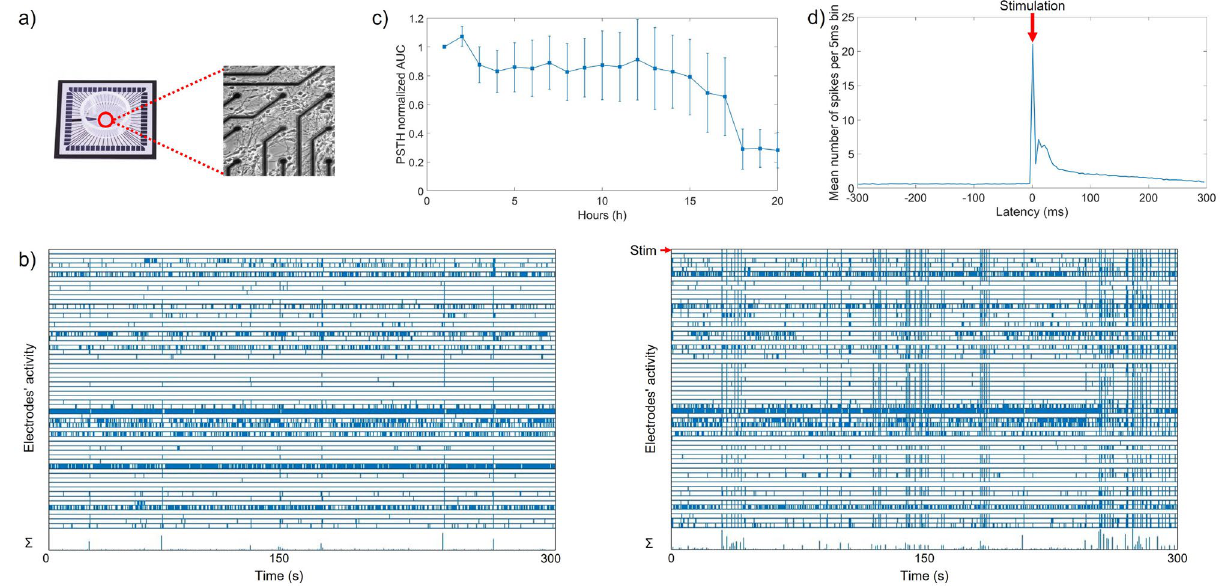
Figure 1. Micro electrode arrays (MEA), recorded activity and post stimulus response. Panel ( a ) shows an example of MEA with a zoom on a section of recording electrodes surrounded by several neurons. ( b ) Shows raster plots of 5 min of spontaneous activity before stimulation (left) and 5 min of activity recorded during electrical stimulation (right) Bottom pannels of both plots show summed activity in 1s bins ( (cid:31) ), top panels indicate stimulation ( c ) Time course of the area under the curve (AUC) of the post stimulus histogram (PSTH) averaged across experiments. Here AUC was normalized to the first stimulation hour, given that 75% of all hours were normally distributed error bars indicate SEM. ( d ) example of the averaged post stimulus response during 1 h of stimulation. Horizontal axis shows latency respective to the time of stimulation. Vertical axis shows network wide counted action potentials in 5ms